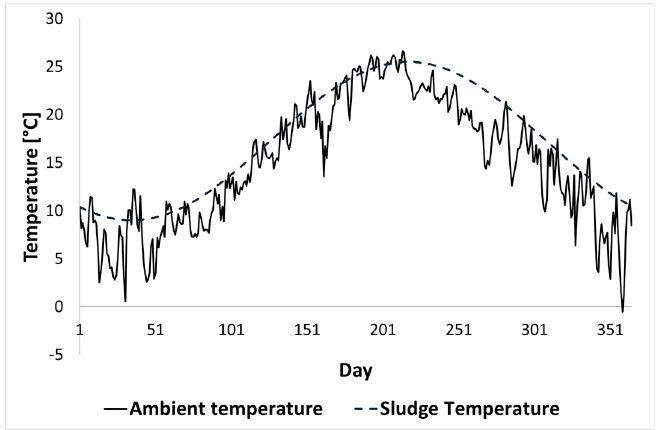
Figure 4. The ambient and daily average sludge temperature.